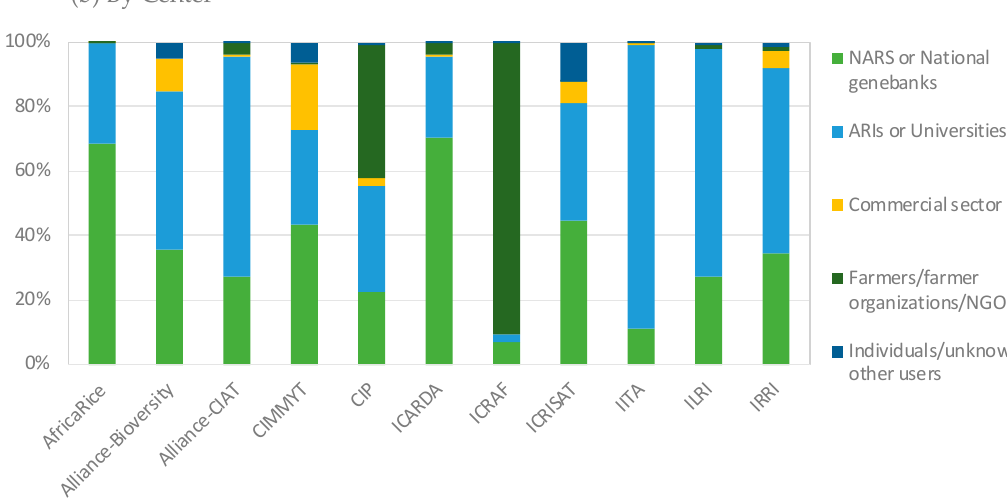
Figure 4. Recipients of germplasm distributed by CGIAR genebanks, 2017–2019.